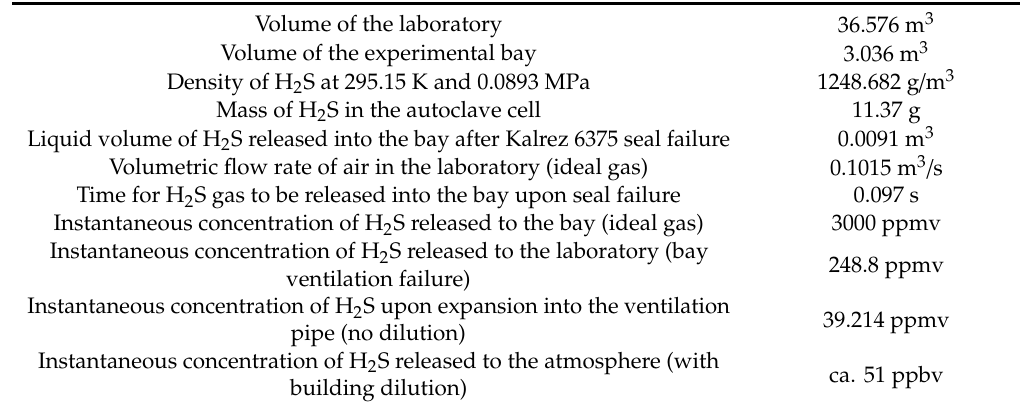
Table 2. Dimensions of the experimental bay, laboratory, and calculated concentration of H 2 S